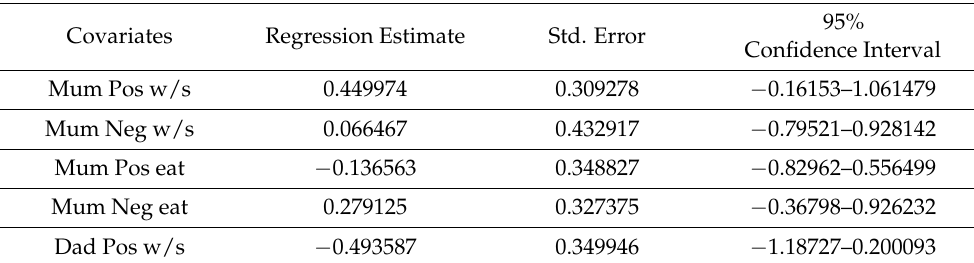
Table 3. Multiple linear regression results for the effects of maternal and paternal comment variables on psychological distress, BMI, eating disorder cognitions, and paediatric quality of life at one-year follow-ups for